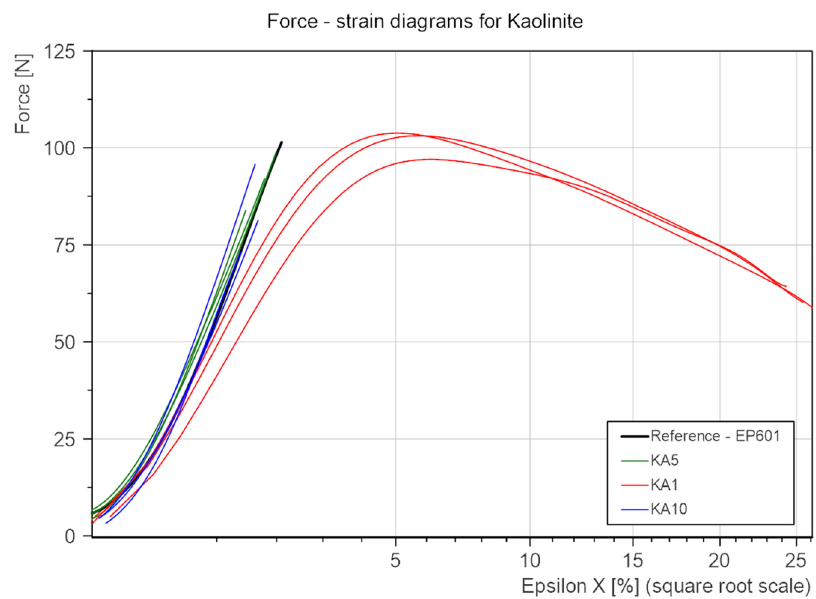
Figure 12. Bending force-tensile strains for KA .